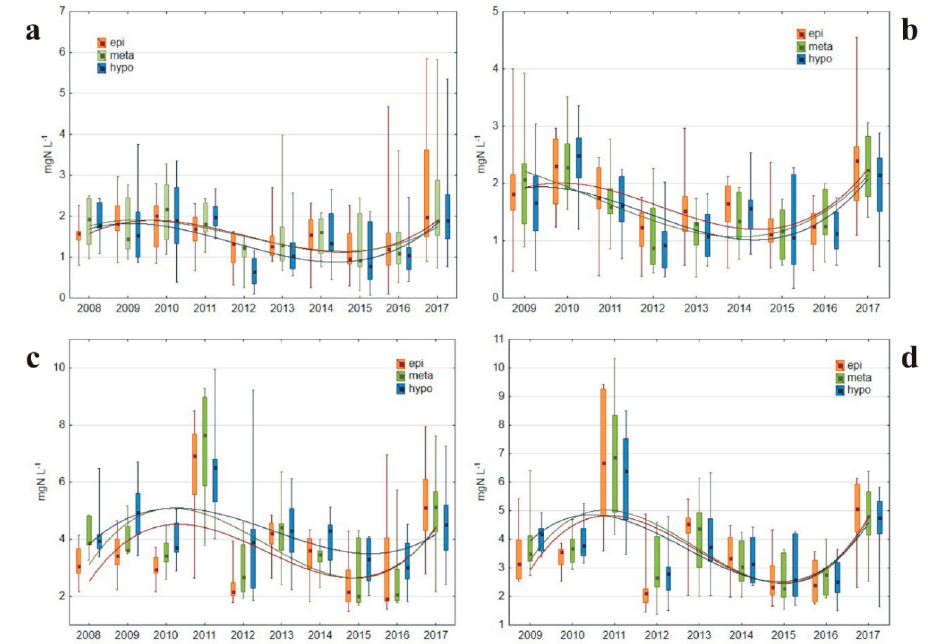
Figure 9. Box plot with min-max of nitrogen compounds in selected water layers: organic N at Station I ( a ) and Station II ( b ); and total N at Station I ( c ) and Station II ( d ). The lines indicate polynomial trendlines for water layers.